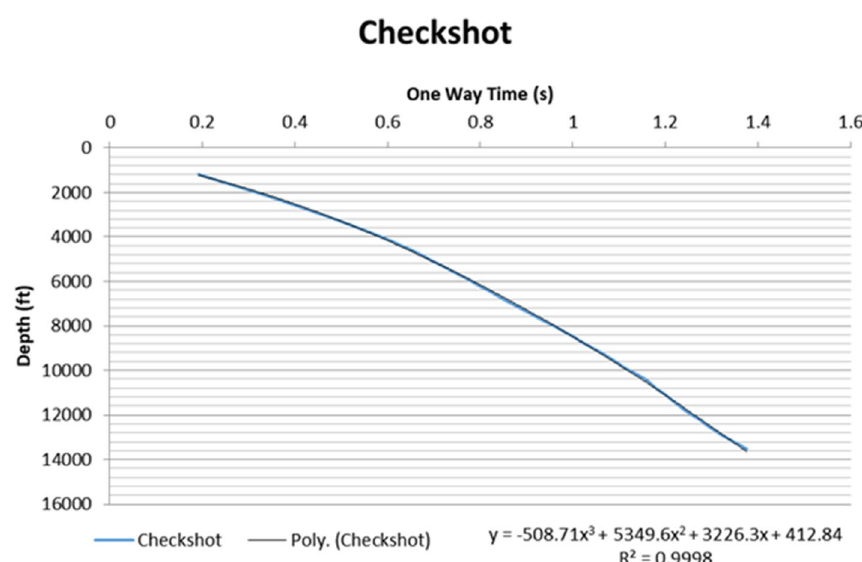
Fig. 7 Plot of check shot data used as the time-depth